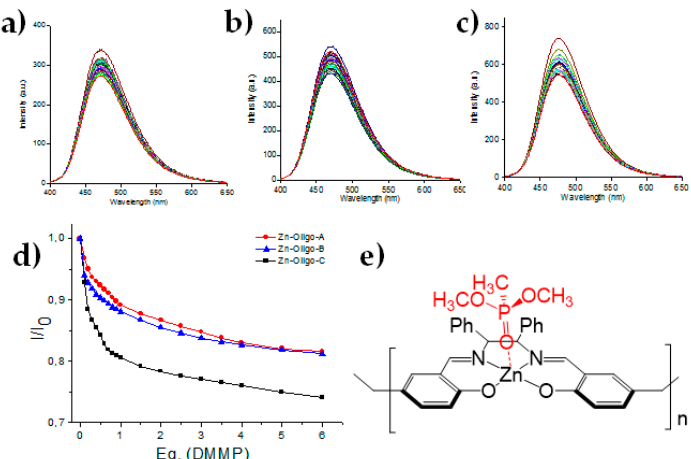
Figure 9. Fluorescence emission spectra of ( a ) Zn–Oligo–A, ( b ) Zn–Oligo–B, and ( c ) Zn–Oligo–C upon progressive addition of 0–6 eq. of DMMP ([receptors] = 1 × 10 − 5 M in DMSO, λ ex 365 nm); ( d ) normalized fluorescence emission variation relative to Zn–Oligo–A (red), –B (blue), and –C (black) solutions (1 × 10 − 5 M in DMSO, λ ex 365 nm), upon addition of DMMP (0–6 eq.); ( e ) supramolecular host–guest complex proposed.